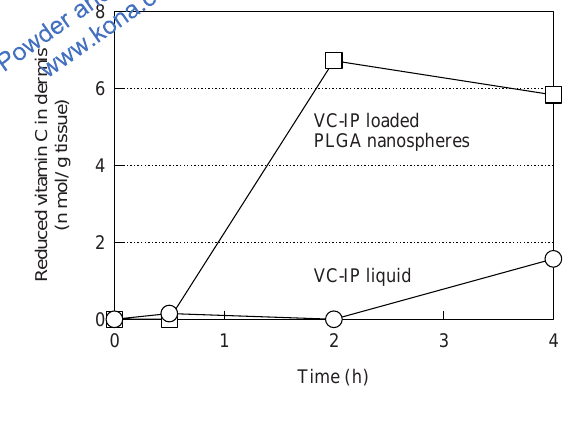
Fig. 16 Comparison of the amount of ascorbic acid in the dermis delivered by the PLGA nanoparticle and liquid suspen-